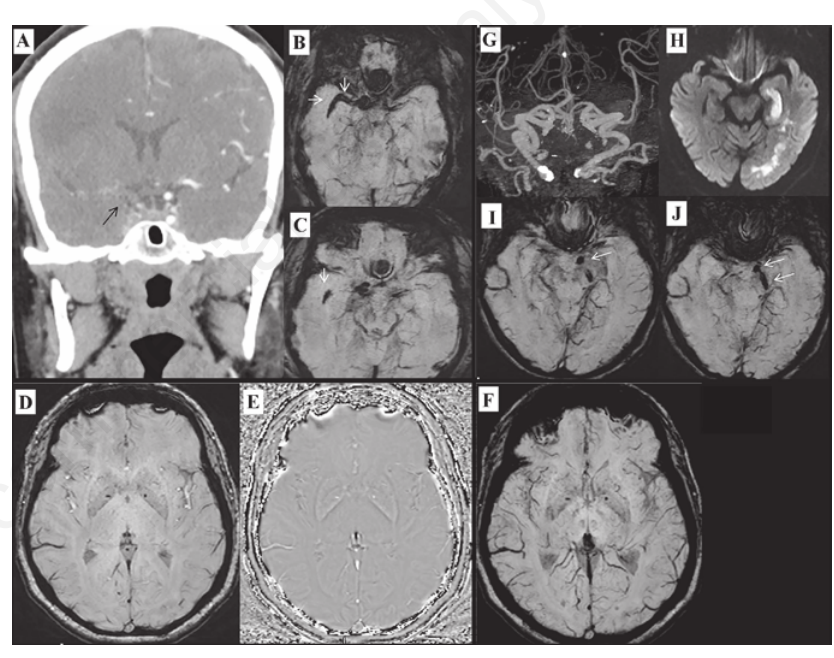
Figure 3. A-C) A 52-year-old female presenting with acute left-sided weakness. A) CT angiogram (MIP image) shows non-visualtion of the right ICA and the MCA(arrow) with no reconstitution of the distal branches. The presence and extent of thrombus into the MCA cannot be delineated on CTA. B,C) Two contiguous SW-mIP axial images show